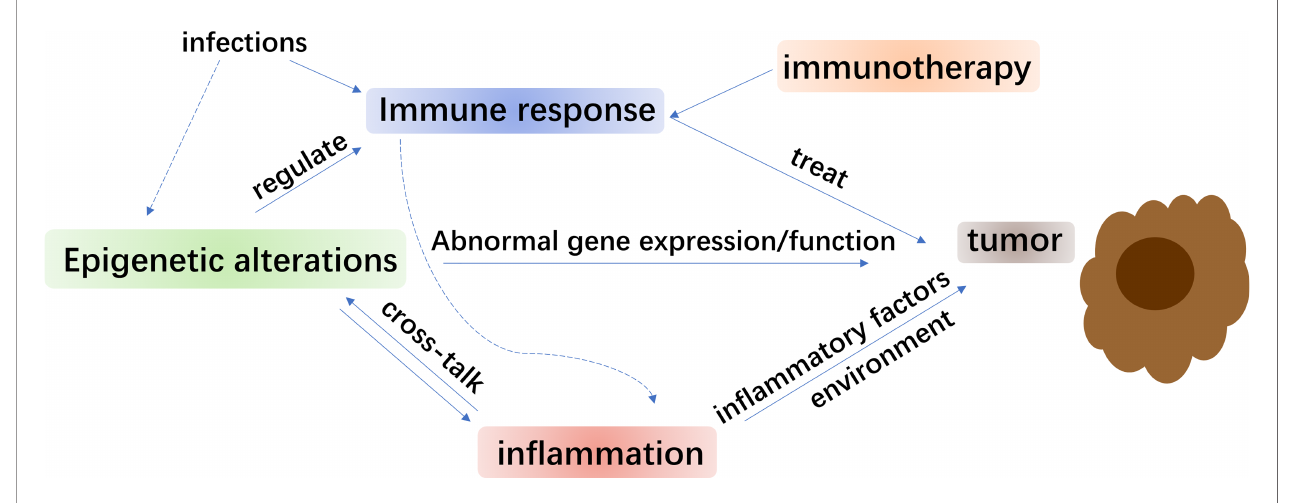
FIGURE 1 | Schematic diagram of